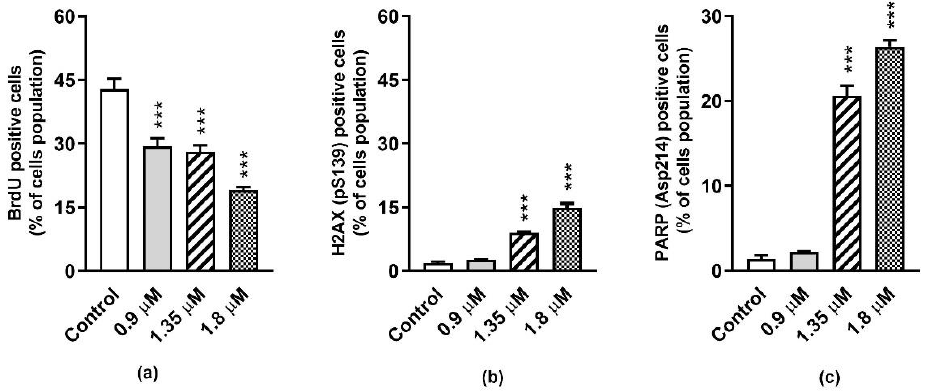
Figure 4. Quantitative analysis of inhibition of cell proliferation (BrdU test); ( a ) induction of apop- tosis (PARP test) ( b ) and induction of DNA damage (H2AX test) ( c ) by 5a (1.8 µM) in HL-60 cells. Data are presented as mean ± SEM of three independent experiments. Statistical significance was assessed using one-way ANOVA and a post-hoc multiple comparison Student–Newman–Keuls test. *** p < 0.001 vs. control.